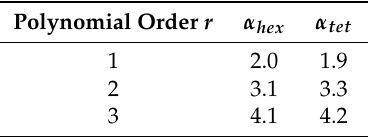
Figure 9. -norm of the error for the smooth, three-dimensional function. ( a ) Hexahedra; ( b ) tetrahedra. L 2 Table 2. Order of accuracy from the numerical convergence study for the smooth, three-dimensional function on hexahedral α hex and tetrahedral α tet grids using